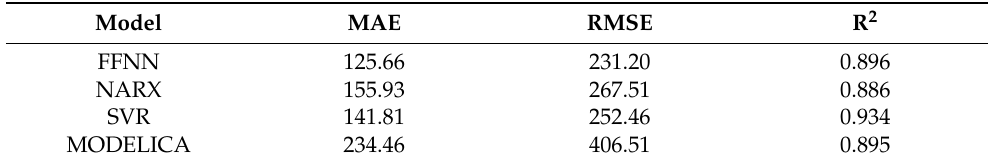
Table 6. Results of the error metrics obtained for the prediction of PV generation during the month of July for all models.